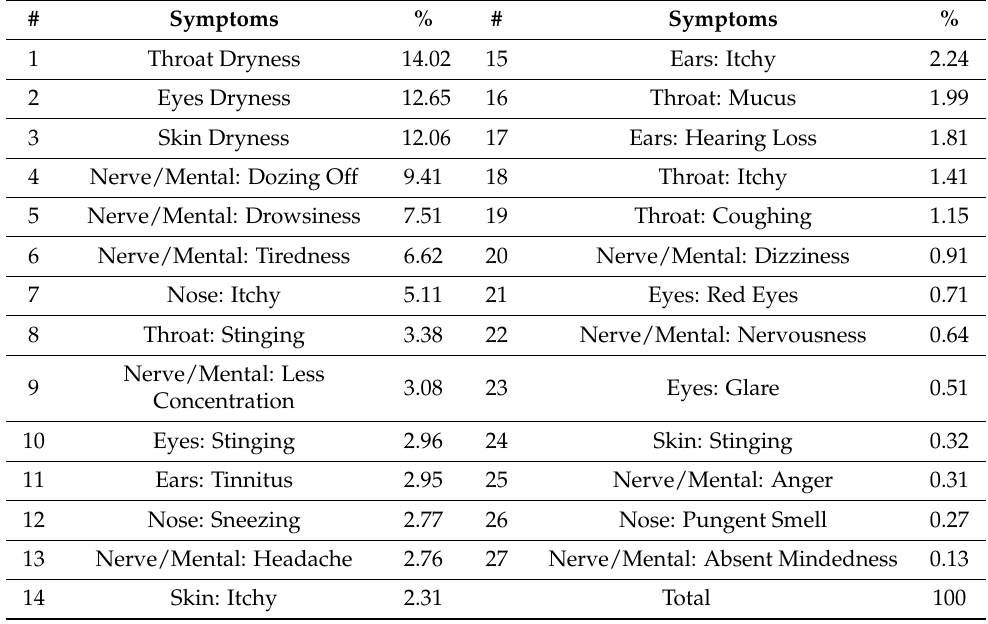
Table 4. Sick building syndrome symptoms and